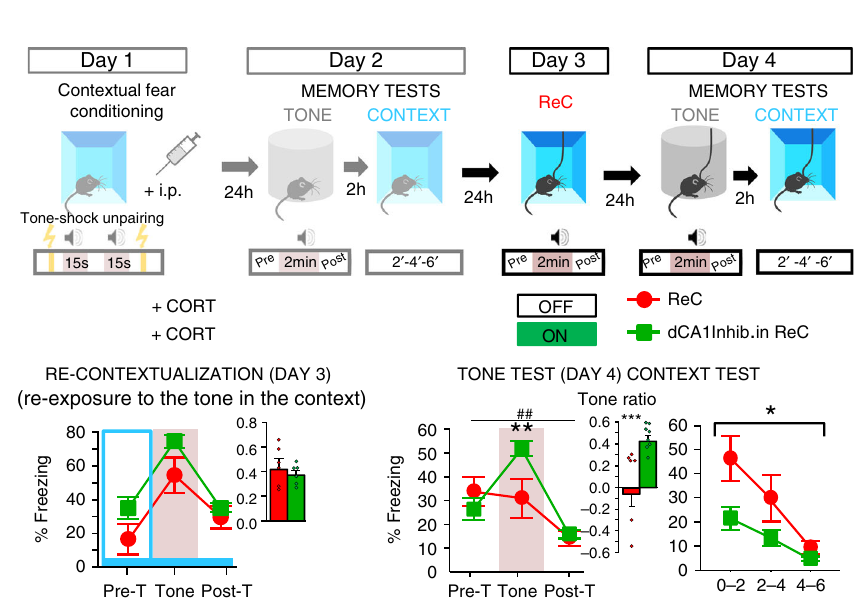
Fig. 3 Trauma re-contextualization is hippocampus-dependent. Top panel, scheme illustration of the behavioral procedure: fear conditioning (Day 1), memory tests (Day 2), trauma re-contextualization (ReC) by complete re-exposure to trauma-related cues (i.e. to the tone in the conditioning context;